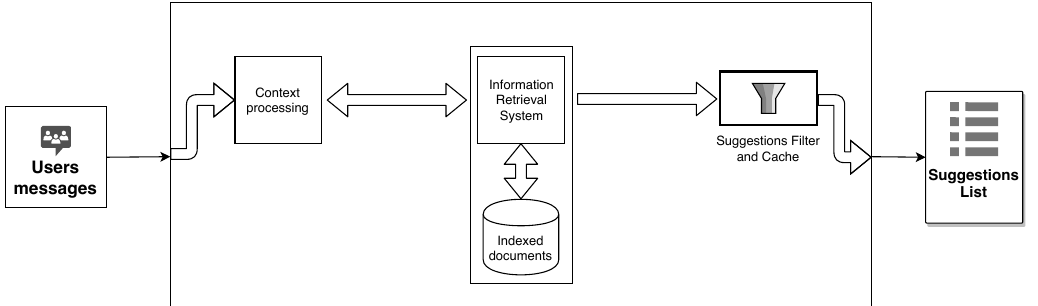
Figure 1. CLASSY architecture, that is essentially divided into three blocks – context processing , responsible to find the most relevant tokens and manage the context; IR system , which has previously indexed the documents that are considered relevant to the users or conversational topics; and suggestions filter and cache , are responsible for analyzing the document list retrieved by the IR system, applying some filters to it, and cacheing the